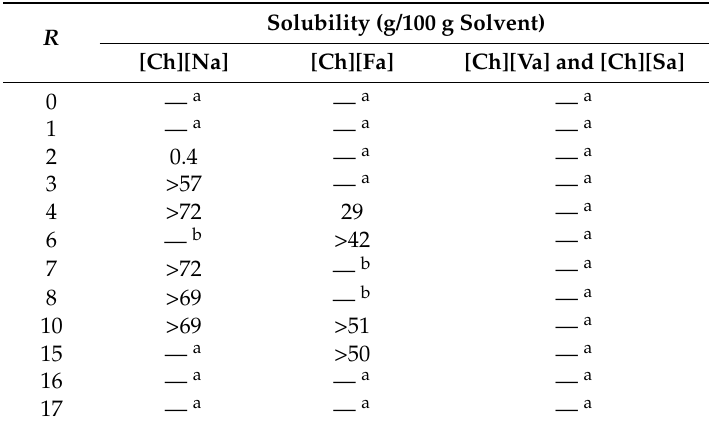
Table 2. Solubility of lignin (alkali) in the H 2 O/choline carboxylate solvent at 25 ◦